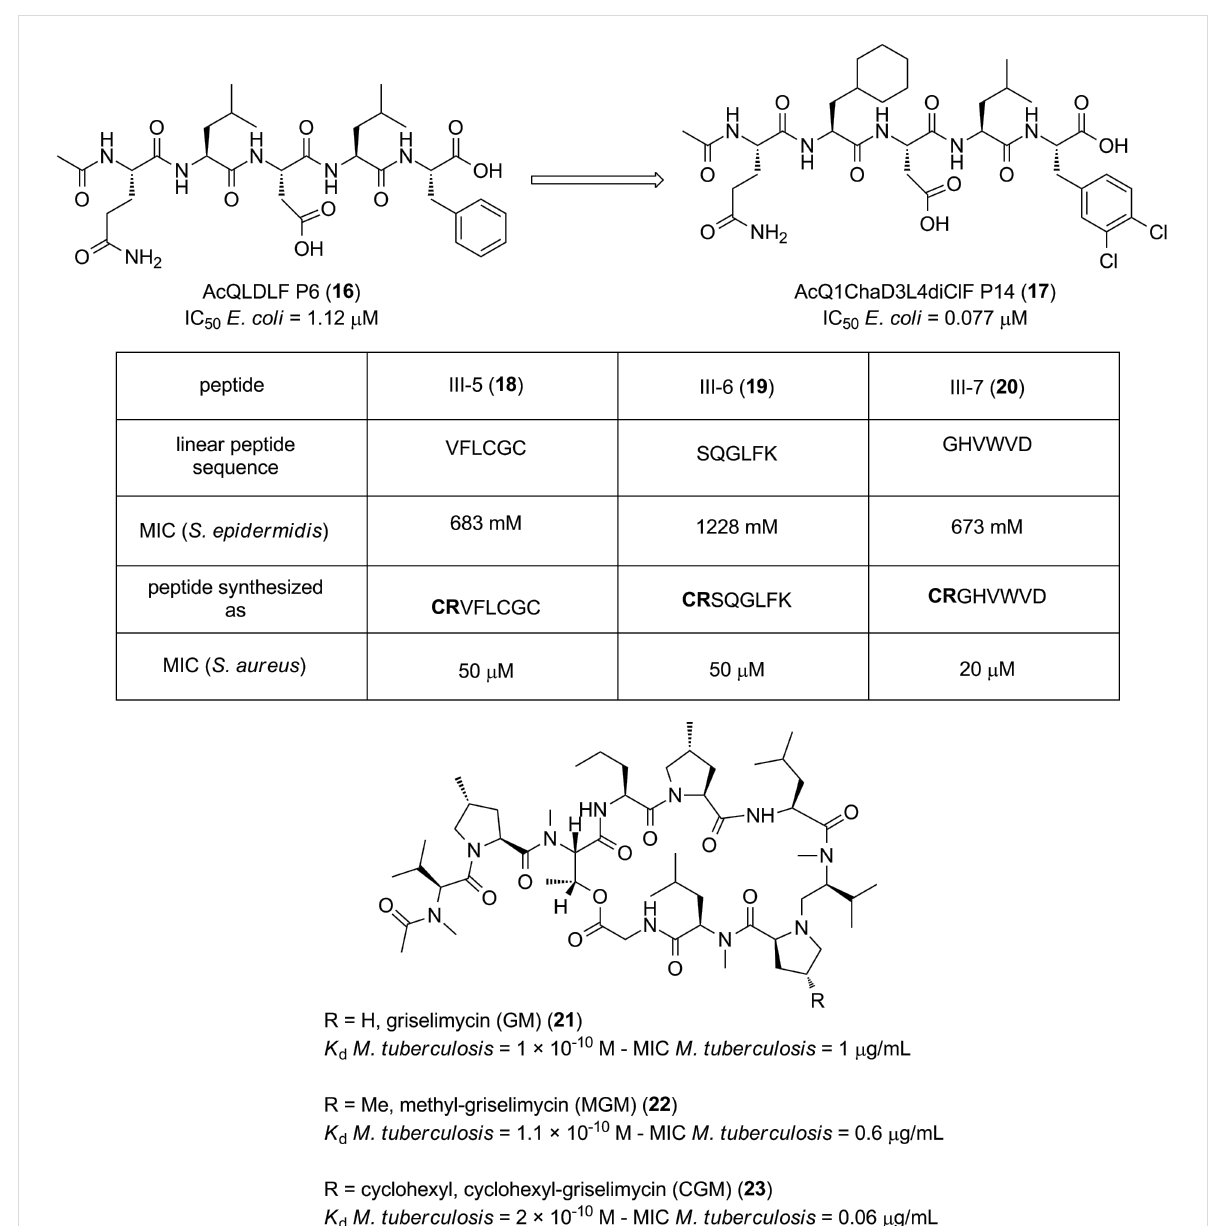
Figure 5: Peptidic inhibitors of PPIs in the sliding clamp.